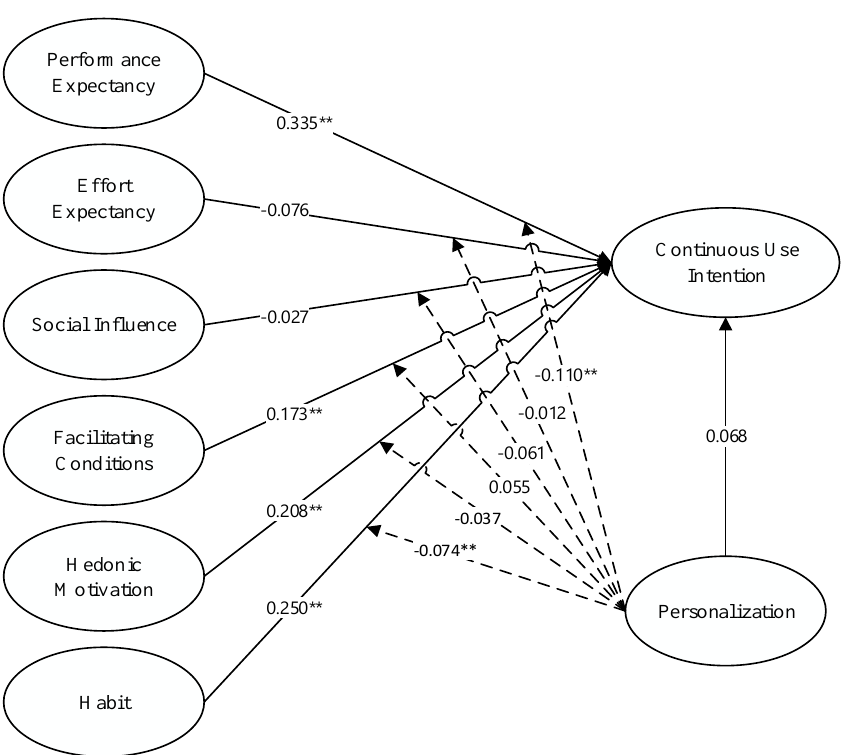
Figure 2. Structural equation model with path coefficients. ** p < 0.01.